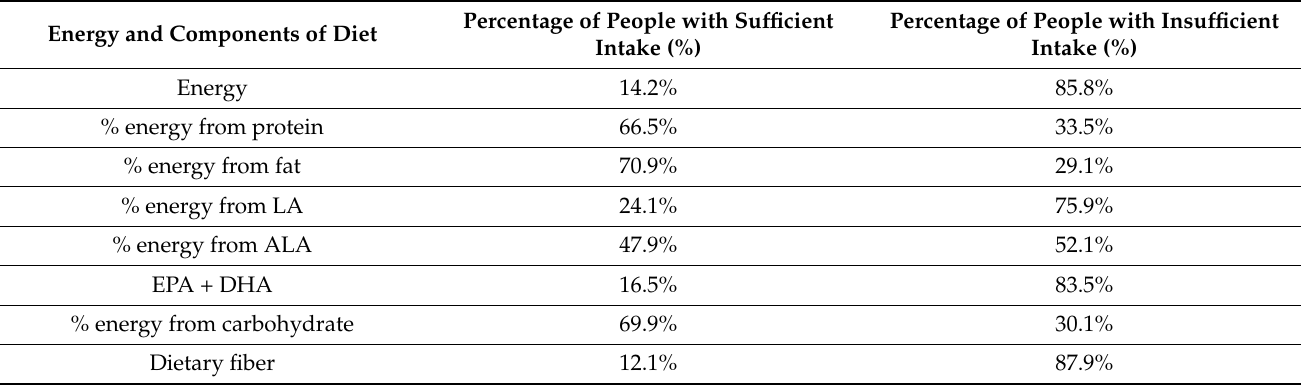
Table 4. Percentage of people with sufficient and insufficient intake of energy and selected